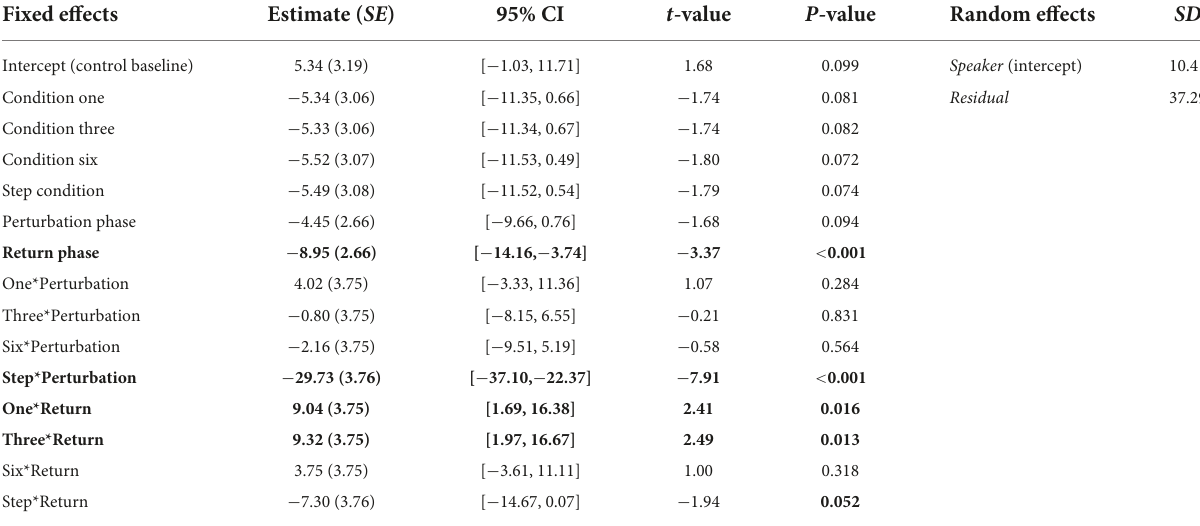
TABLE 3 Coefficients from the Best-Fit Model used to predict speakers’ normalized F1 values during Experiment